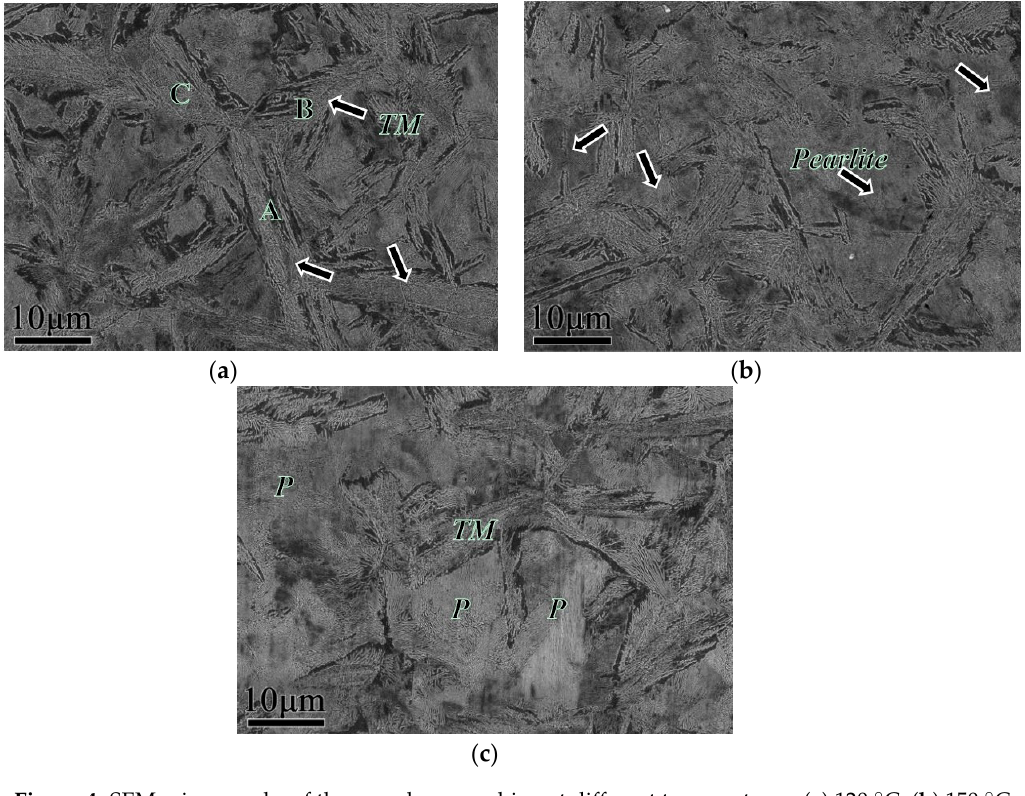
Figure 4. SEM micrographs of the samples quenching at different temperatures, ( a ) 120 ◦ C, ( b ) 150 ◦ C, and ( c ) 190 ◦ C and tempering at 600 ◦ C.